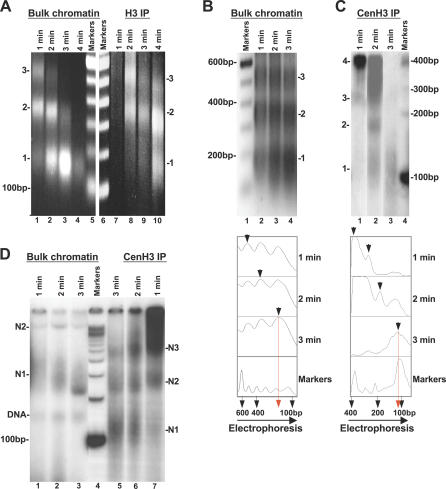
Less DNA Is Protected from Nuclease Digestion of CenH3- Compared with H3-Nucleosomes(A) Ethidium bromide stained 1.5% agarose gel showing DNA obtained from progressively MNase-digested bulk input chromatin (lanes 1–4) and control H3 IP chromatin (lanes 7–10). Both show core particle protection at 150 bp. Marker is 100-bp DNA ladder (Invitrogen).(B) Ethidium bromide stained gel showing purified DNA obtained from dilute MNase digestion of bulk chromatin input has a normal progression yielding a canonical MNase “ladder” and core protection of 150 bp. Marker is 100-bp DNA ladder (Invitrogen). The densitometric scan is presented below.(C) Autoradiogram showing purified DNA obtained from CenH3 immunoprecipitation of MNase-digested chromatin (lanes 1–3). DNA was radioactively end-labeled and resolved on 8% PAGE. The nucleosomal ladder appears relatively smeary and multiples of a unit repeat are not evident. Marker is 100-bp DNA ladder (Invitrogen). Densitometric analysis below demonstrates reduction in CenH3 core protection to approximately 100–120 bp rather than 150 bp seen for bulk chromatin (B). Lane 2 required a lower exposure than the rest of the gel. Marker is 100-bp DNA ladder.(D) Native PAGE of CenH3 IP nucleosomes obtained from successive time points of MNase-digested input (from [B], lanes 1–3) displays faster migration kinetics for CenH3 mononucleosomal species compared to BC species. Nucleosomes are radioactively end labeled in all lanes. Half of the gel containing CenH3 IP (lanes 5–7) needed a 5× longer exposure time than BC (lanes 1–3). The sharp band (DNA) is most likely free mononucleosomal DNA, and species N1, N2, and N3 refer to successive nucleosomal species. Marker is 100-bp DNA ladder.